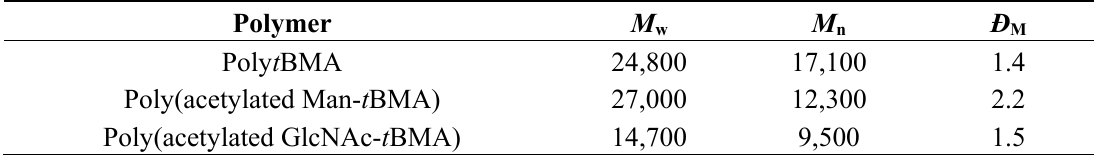
Table 1. Weight-average molecular weight ( M and Đ of poly(glyco-MA) species synthesized in solution, determined by size exclusion M chromatography